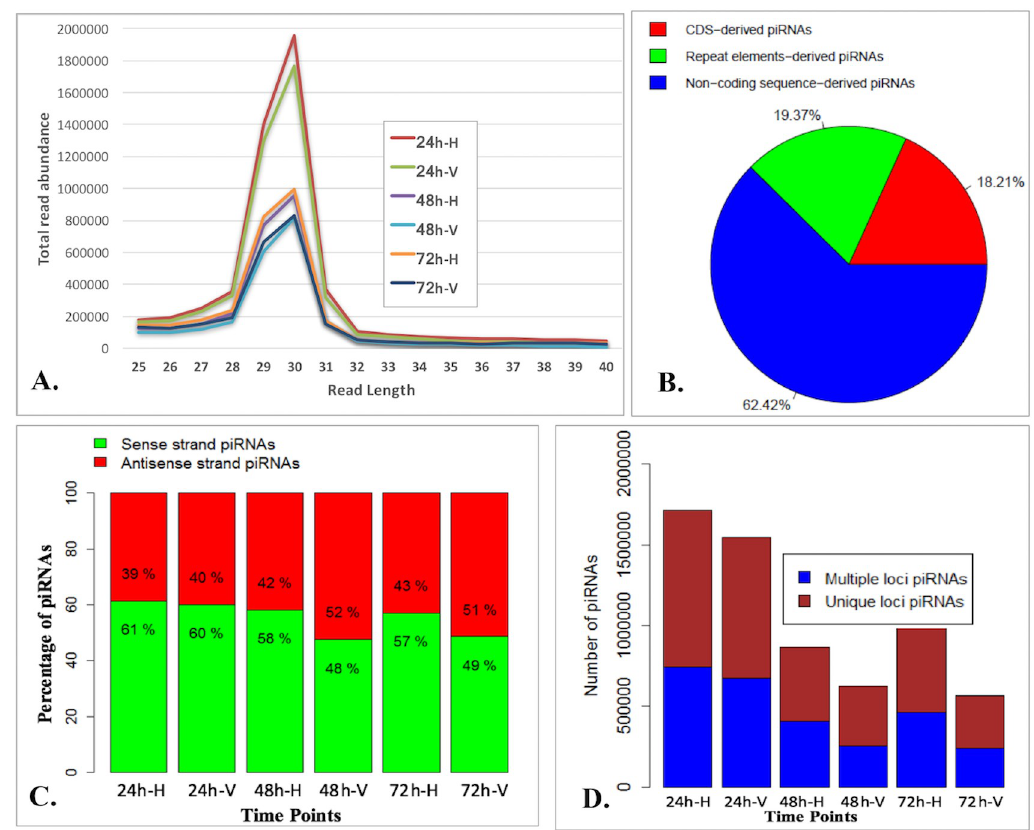
Fig 1. A. Distribution of sRNA read lengths. Size distribution of sequence reads with peaking at 28–31 nt which is usual size range for piRNAs. Horizontal axis provides read length and vertical axis provides total number of reads at specific length. 24 h- H, 48 h-H, and 72 h-H represents whiteflies fed on uninfected tomato for 24, 48 and 72 hours, respectively. 24 h-V, 48 h-V, and 72 h-V represents whiteflies fed on TYLCV-infected tomato for 24, 48 and 72 hours, respectively. Fig 1B. Distribution of piRNAs in different genomic regions. Percentage of all identified piRNAs mapping to different genomic features. Red color denotes piRNAs derived from coding sequences (CDS), green color denotes piRNAs derived from repeat elements, and blue denotes piRNAs derived from non-coding sequences including intergenic regions, introns and UTRs. C). Distribution of piRNAs based on strand. Green color denotes percentage of piRNAs derived from sense strand whereas brown color denotes percentage of piRNAs derived from antisense strand. D). Distribution of piRNAs based on mapping to number of genomic loci. Blue color denotes piRNAs mapped to multiple genomic loci whereas brown color denotes piRNAs mapped to single unique genomic loci. 24 h-H, 48 h-H, and 72 h-H represents whiteflies fed on uninfected tomato for 24, 48 and 72 hours, respectively. 24 h-V, 48 h-V, and 72 h-V represents whiteflies fed on TYLCV-infected tomato for 24, 48 and 72 hours, respectively.